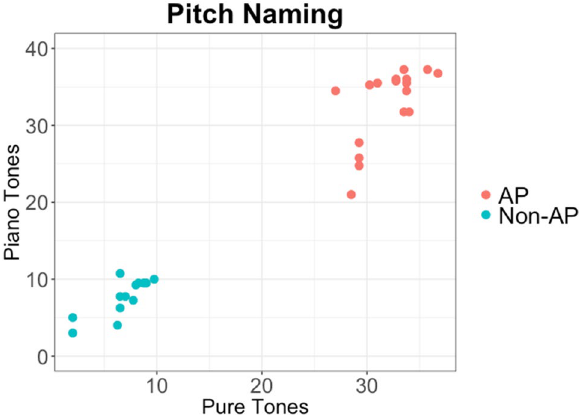
Figure 2. Distribution of AP and Non-AP subjects across the identification of piano (Y-axis) and pure tones (X-axis).